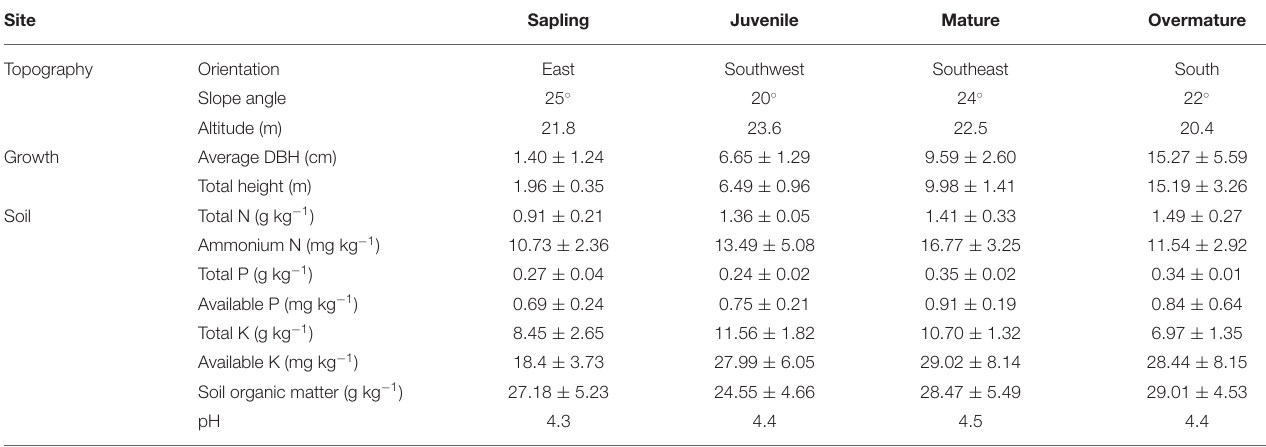
TABLE 1 | Stand and site information of sapling (5-), juvenile (15-), mature (25-), and overmature (35-years old) Chinese fir ( Cunninghamia lanceolata ) stands; data represent means ± SE ( n = 5). Site Sapling Juvenile Mature Overmature Topography Orientation East